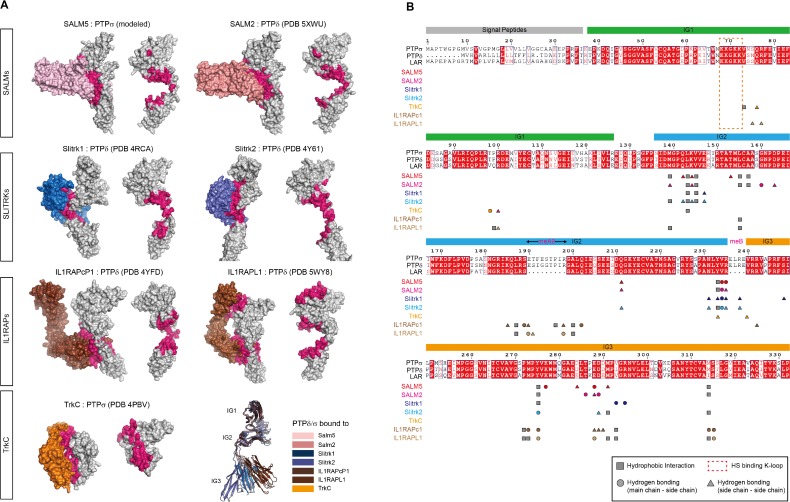
PTPσ adhesions with known postsynaptic partners, and identification of the amino acid residues involved in the interactions.(A) PTPσ adhesions with known postsynaptic partners based on reported complex structures and molecular modeling of the SALM5-PTPσ complex. (B) Amino acid residues involved in the interactions between PTPσ and PTPσ-binding postsynaptic adhesion molecules based on reported or modeled complex structures. Note that IL1RAPL1 and IL-1RAcP have been shown to interact with PTPδ but not PTPσ (Yamagata et al., 2015; Yoshida et al., 2012; Yoshida et al., 2011).